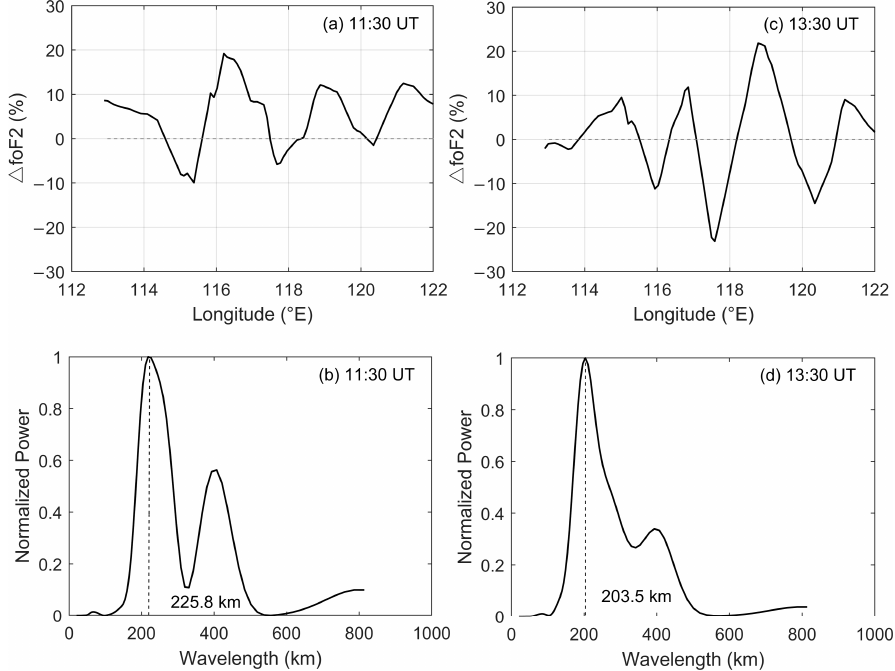
Figure 5. Variations of the ∆ f o F2 variations along 38 ◦ N latitude from 113 to 122 ◦ E longitude and the corresponding horizontal wavelength of the recorded waves. The upper panels display the ∆ f o F2 variations observed at ( a ) 11:30 UT and ( c ) 13:30 UT. ( b , d ) The relevant spectrum analysis results. The estimated wavelength is indicated by the vertical dotted